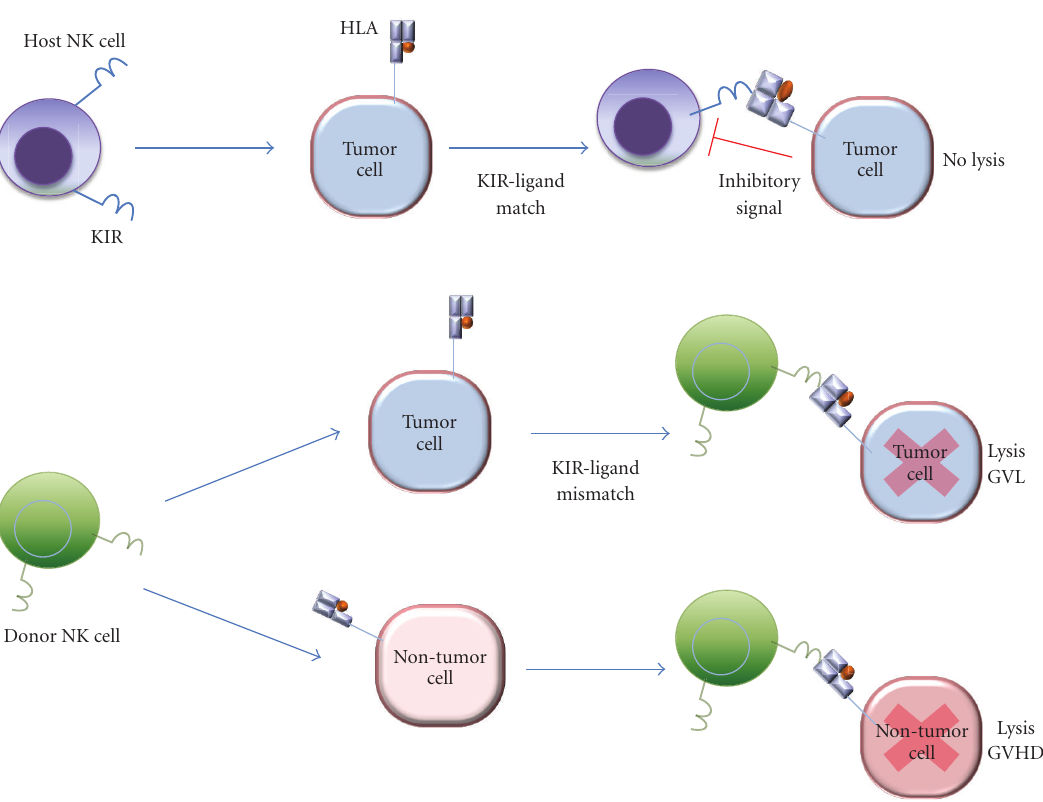
Figure 2: NK cell tumor immunity and alloimmunity after allogeneic ACT. Autologous NK cell killing is inhibited when self-class I MHC on tumor cells is recognized. In allogeneic ACT, NK cell KIR-mismatch is implicated both in GVHD and in mediating of a GVL e ff ect.